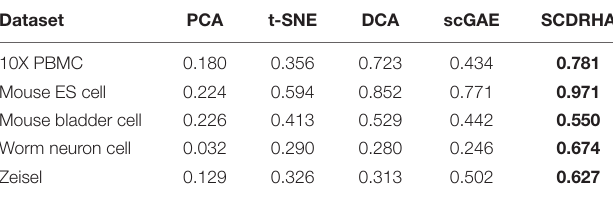
TABLE 4 | ARI score under different datasets.